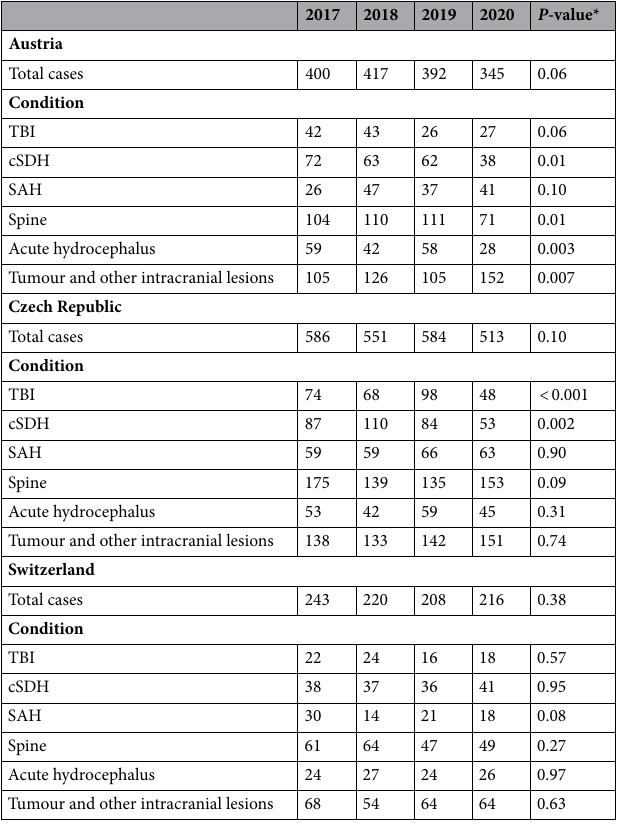
Table 2. The incidence of non-elective neurosurgical cases in Austria, Czech Republic and Switzerland from March 16th until April 15th 2017–2020. TBI Traumatic brain injury, cSDH chronic subdural hematoma, SAH subarachnoid haemorrhage and other vascular pathologies. *P-values derived from chi-square